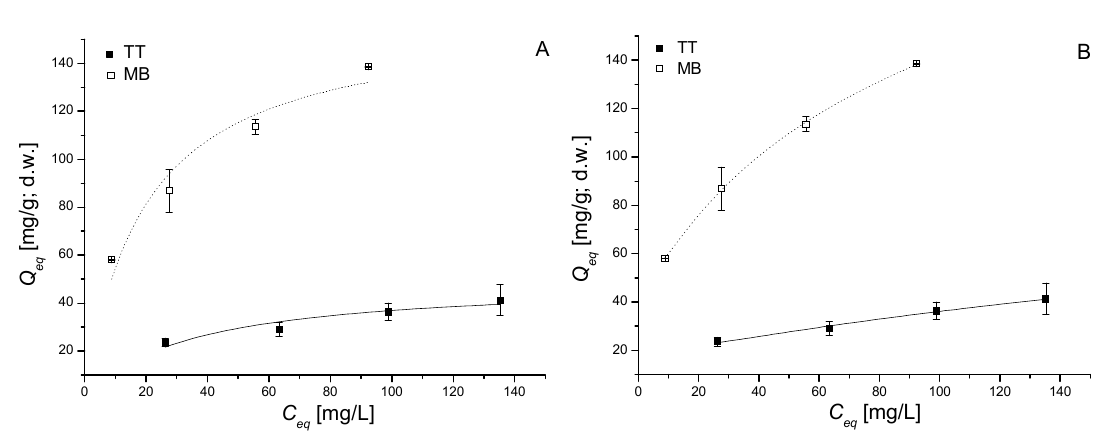
Figure 6. Fit of the Langmuir ( A ) and Freundlich ( B ) isotherms of thioflavin T (TT) and methylene blue (MB) biosorption by dried biomass of freshwater moss V. dubyana ( C B = 0.5 g/dm 3 ) from binary sorption